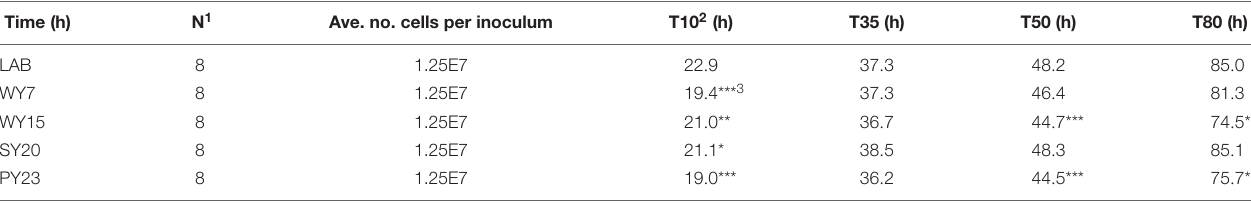
TABLE 5 | Impact of MED15 Alleles from Industrial Yeast on Times to Equivalent Weight Loss. Time (h) N 1 Ave. no. cells per inoculum T10 2 (h) T35